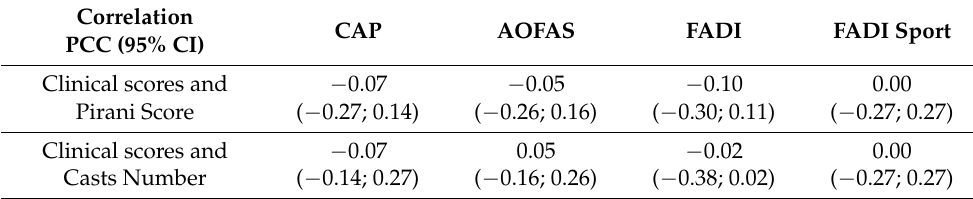
Table 3. Clinical assessment and